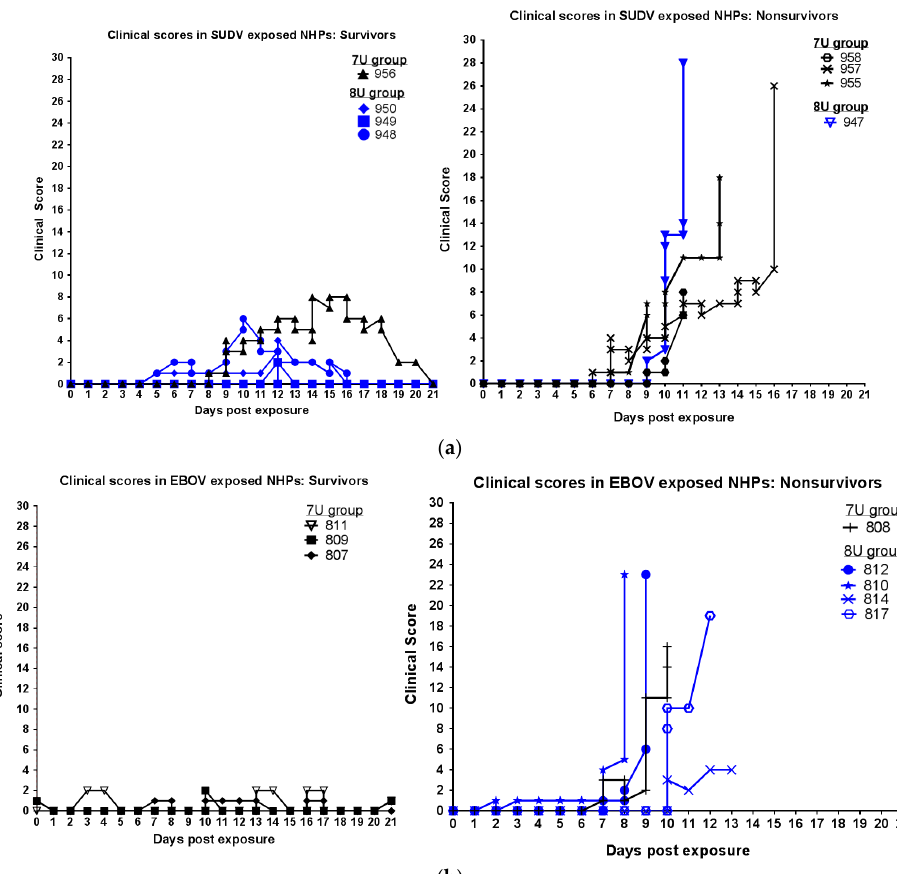
Figure 2. Clinical scores in M. fascicularis experimentally exposed to 0.01 plaque-forming units of either Sudan virus (SUDV) or Ebola virus (EBOV) with a 7-uridine (7U) or 8-uridine (8U) genotype. NHPs—nonhuman primates. ( a ) Clinical scores of SUDV-exposed NHPs. ( b ) Clinical scores of EBOV-exposed NHPs (8U exposed animals described previously in [15]).